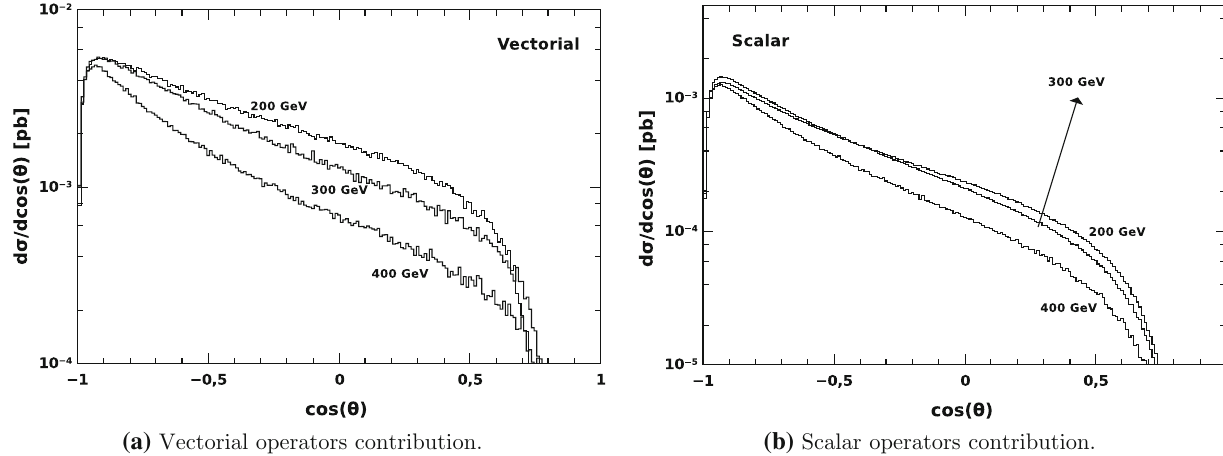
(b) Scalar operators contribution. Fig. 5 Angular distribution for the contribution to the cross section of vectorial and scalar operators for different Majorana neutrino